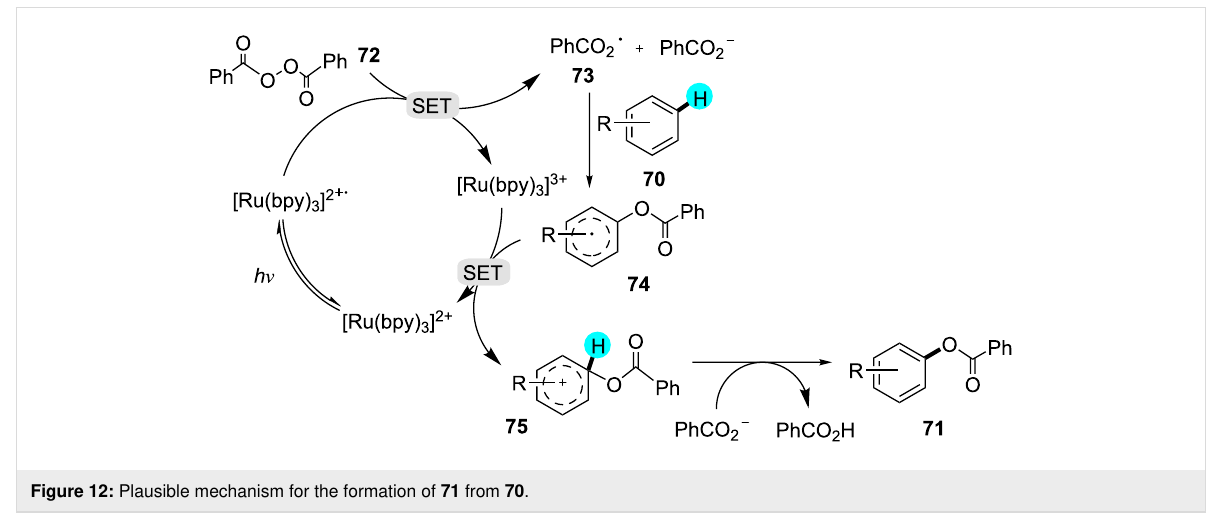
Figure 12: Plausible mechanism for the formation of 71 from 70 .